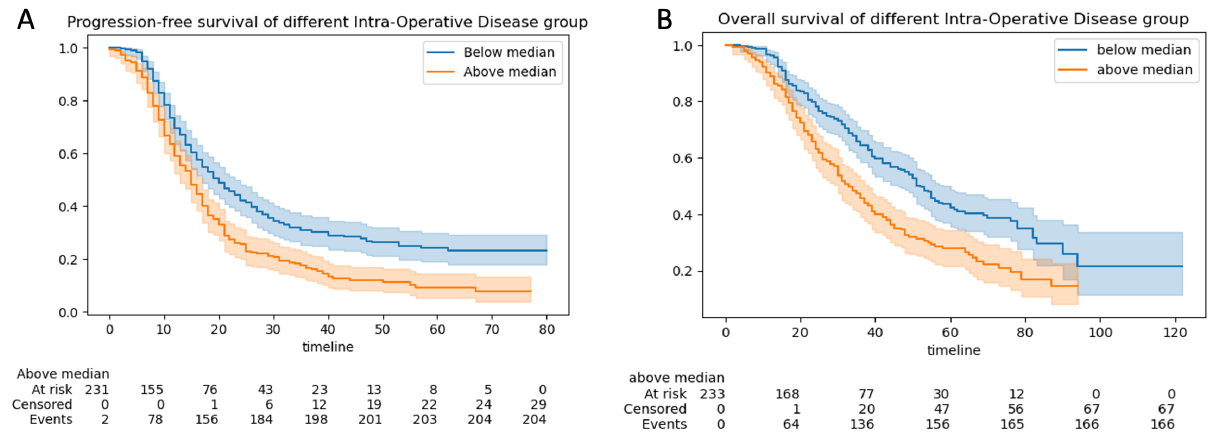
Figure 7. Cohort survival outcomes. Kaplan–Meier curves demonstrating ( A ) progression-free survival (PFS) and ( B ) overall survival (OS) analyzed by >median ANAFI intra-operative disease score and <median ANAFI intra-operative score groups. The blue line represents the patients with <median ANAFI intra-operative disease scores, and the orange line those with >median ANAFI intra-operative disease